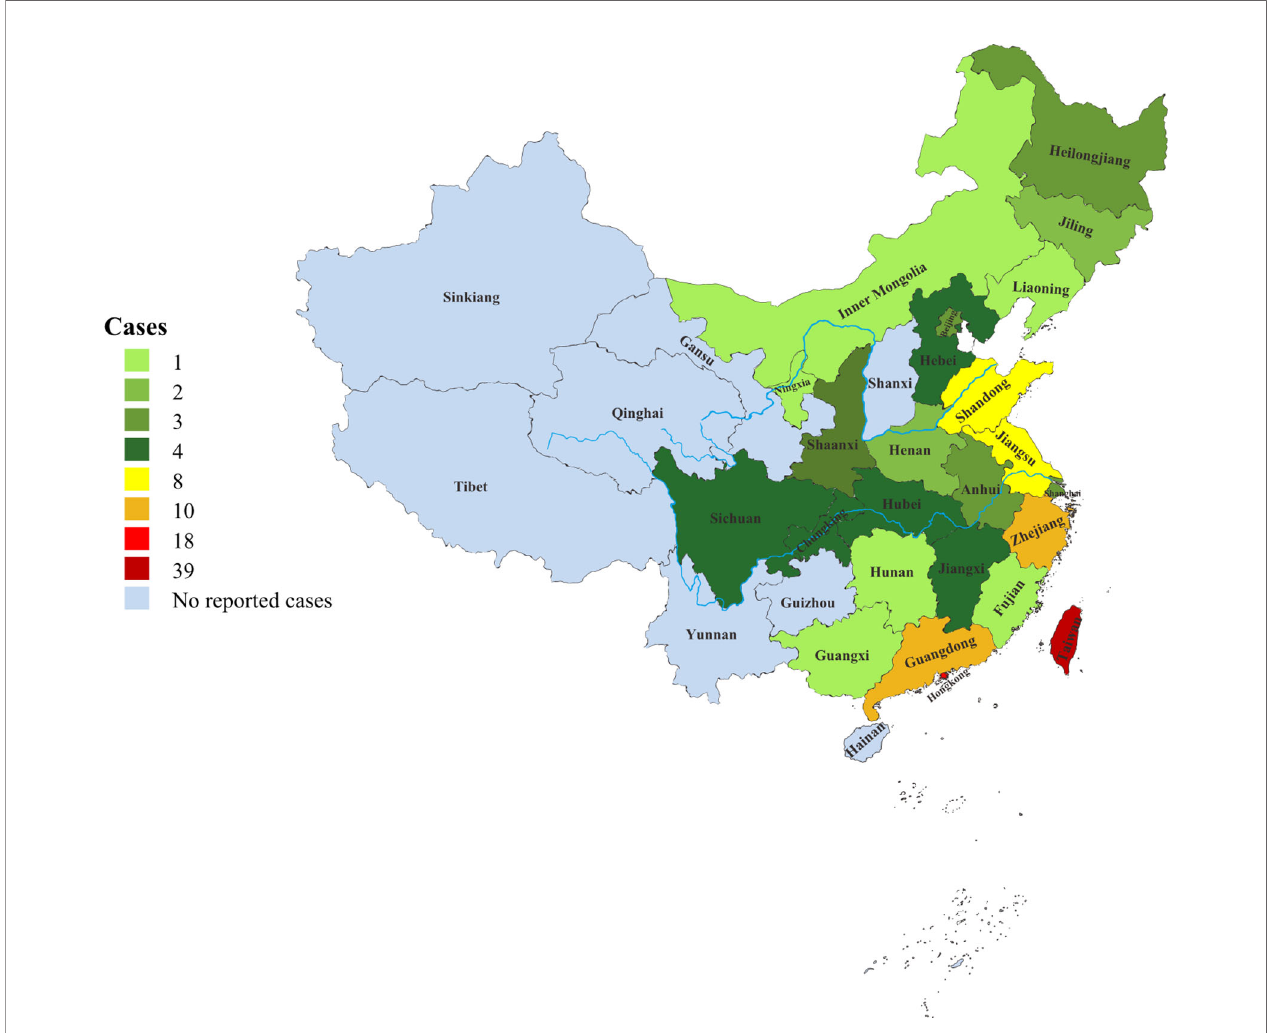
FIGURE 2 | The distribution patterns of PHM in China.